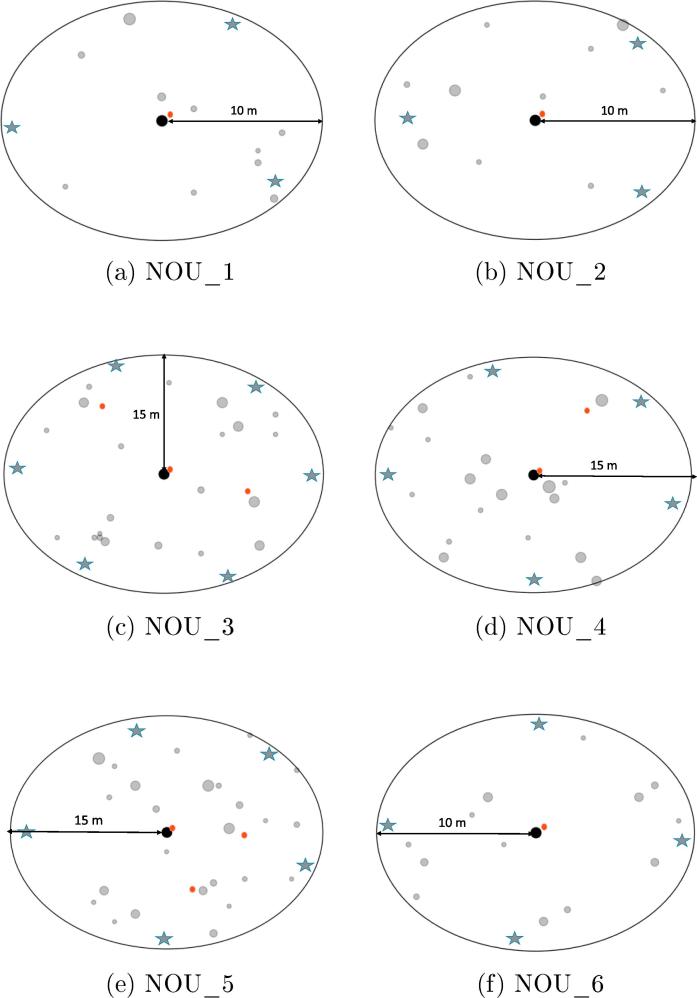
Scanning protocol for all the plots in Nouragues, French Guiana. ( Scan position,  target tree,  lianas in the plot and  other trees (> 10 cm) in the plot). Size of  and  circles reflects the relative size (DBH) of the tr.ees in the plot.